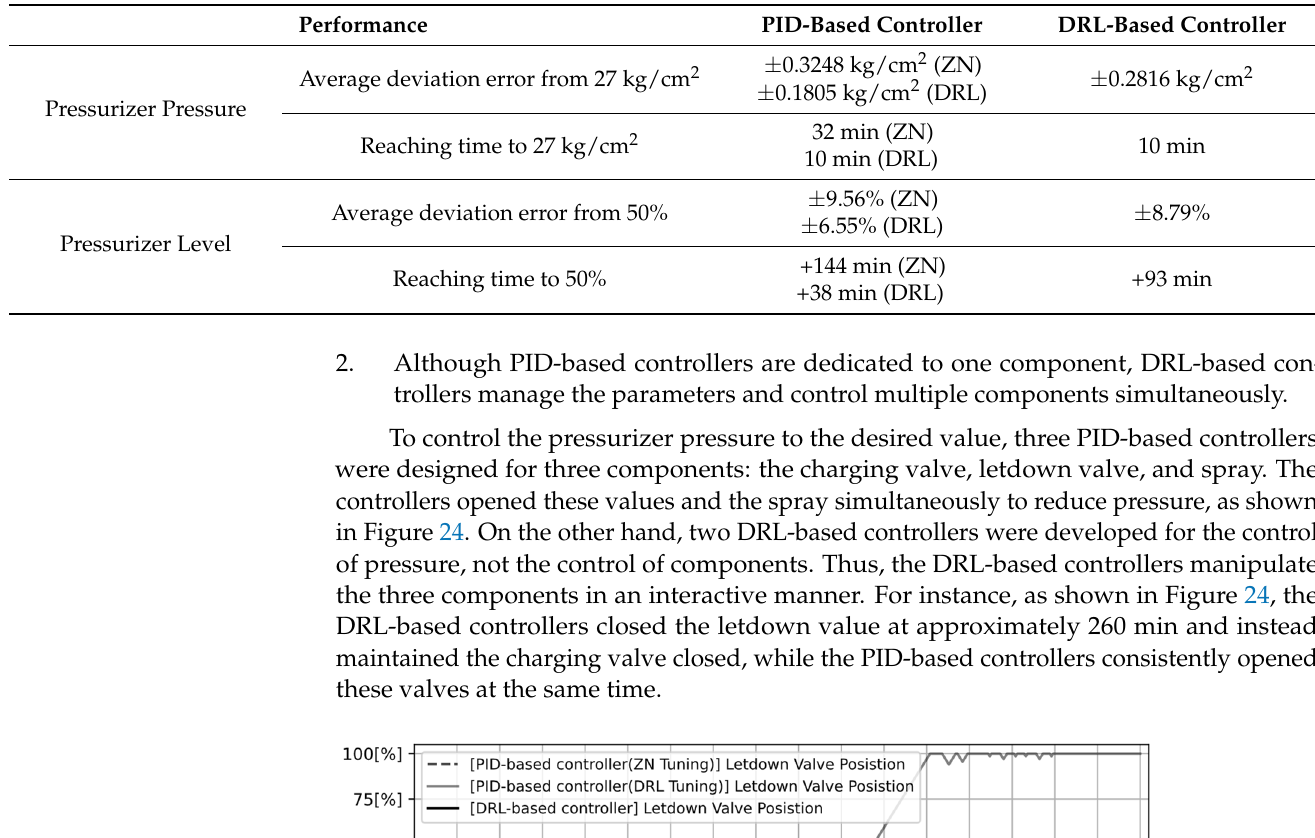
Table 7. Comparison result of operational performances.